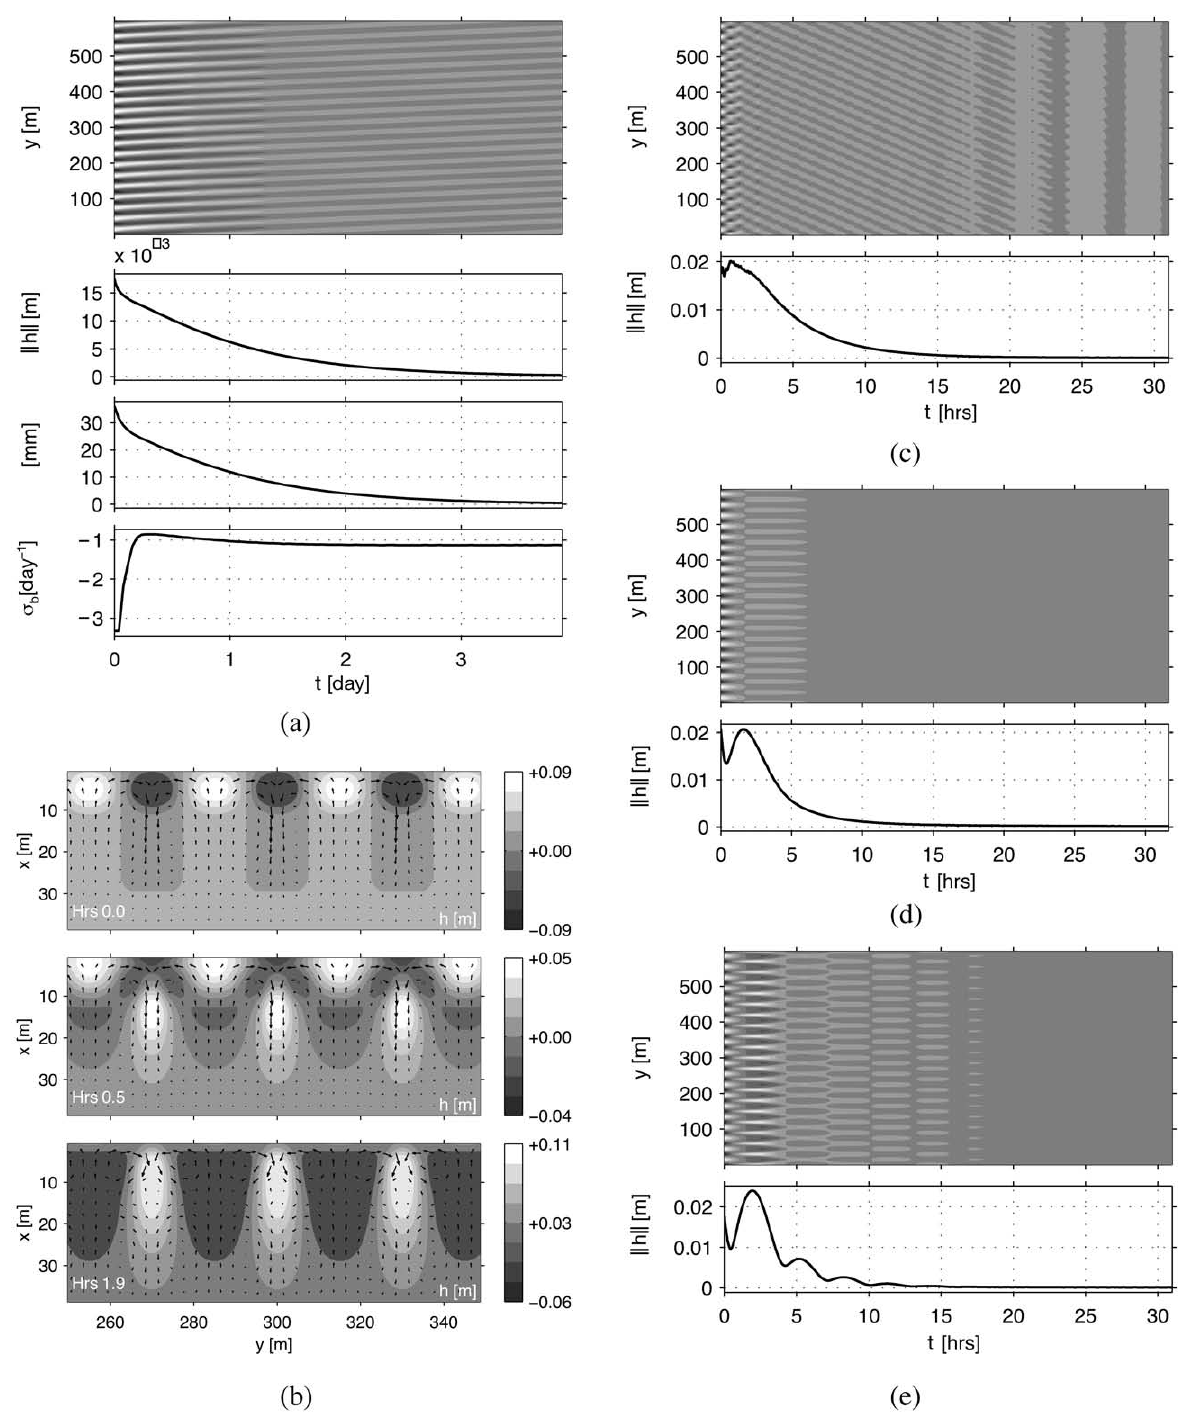
Fig . 11. – Damping of pre-existing cusps. (a) Time series for θ 0 =1°: h(x=5 m,y), |h|, the Fourier coefficient of the predominant mode and s (b) Snapshots of the bed perturbation h and current vectors for a=a